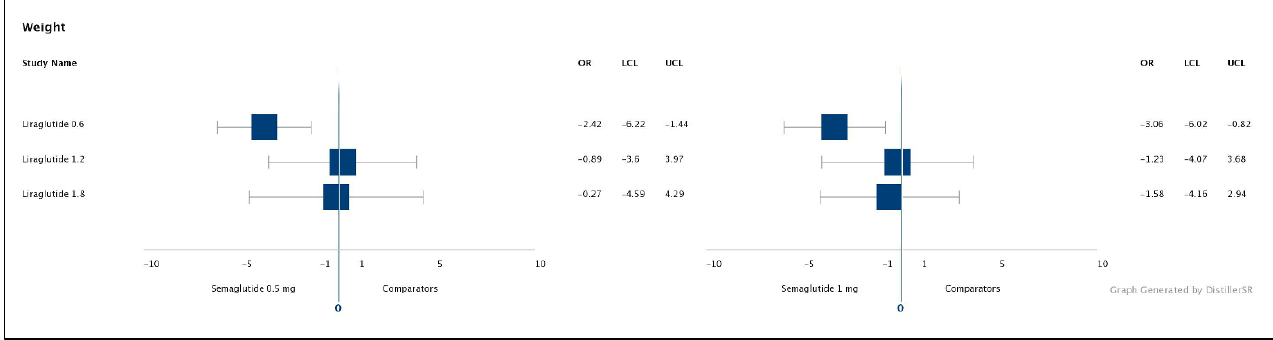
Figure 5. Forest plots of the NMA results: weight outcomes for primary comparators. The NMA results are presented as